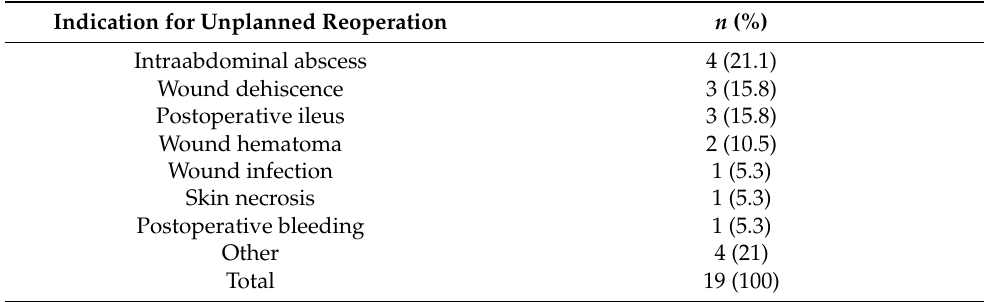
Table 6. Indications for unplanned reoperations.